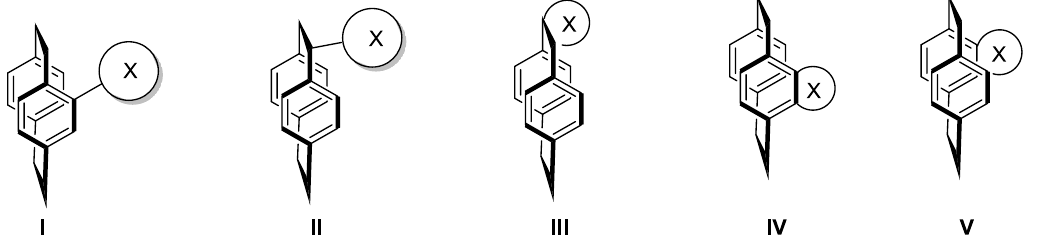
Figure 1. Five types of heterocycle-substituted [2.2]paracyclophanes.